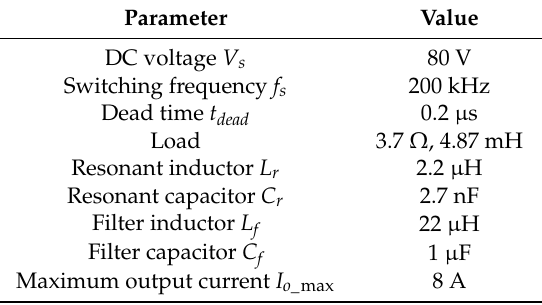
Figure 9. Bode plot of the ARSI with different PI parameters: ( a ) different K p ; ( b ) different K i . Table 2. Parameters of the circuit.